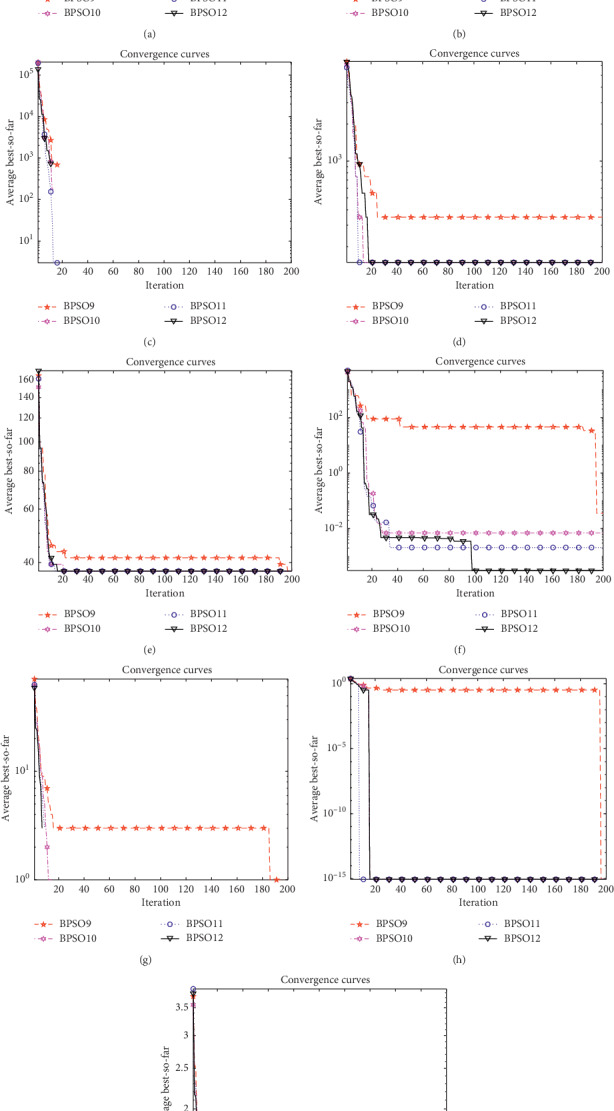
Convergence curves of the benchmark functions under D=5. (a) F1. (b) F2. (c) F3. (d) F4. (e) F5. (f) F6. (g) F7. (h) F8. (i) F9.